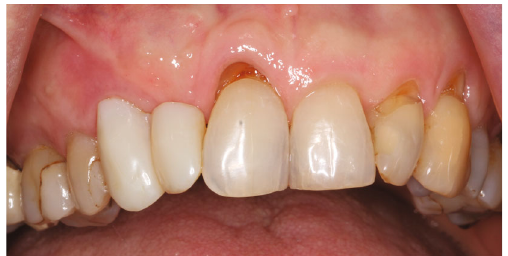
Figure 9: Intraoral view with long-term temporary prosthetics (PMMA) bridge 13-12 in